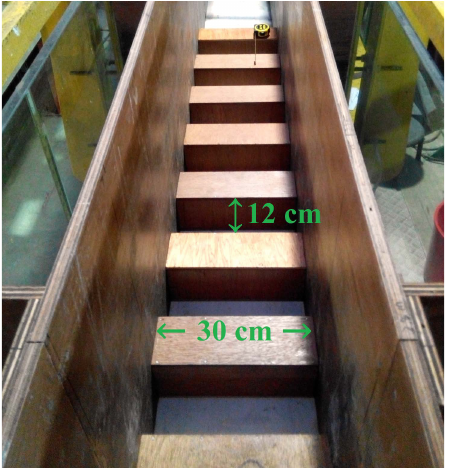
Figure 2. Side view of the recirculating water channel with an adjustable floodgate and a control valve to vary the flow rate and water level. The model blocks are placed at the test section, which is at the middle of the water channel.